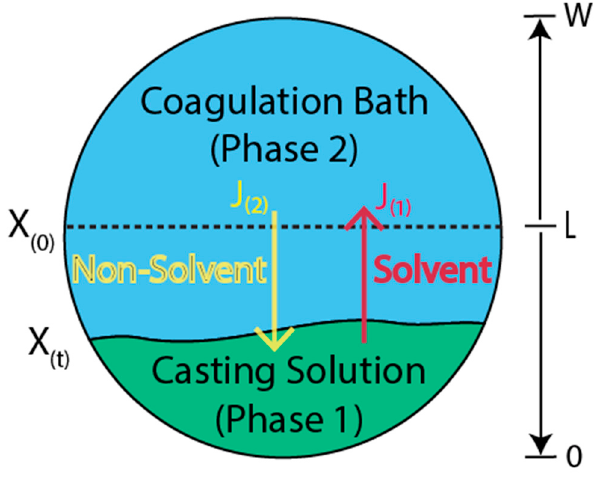
Figure 10. Schematic representation of the phase-inversion process. Adapted from [50].